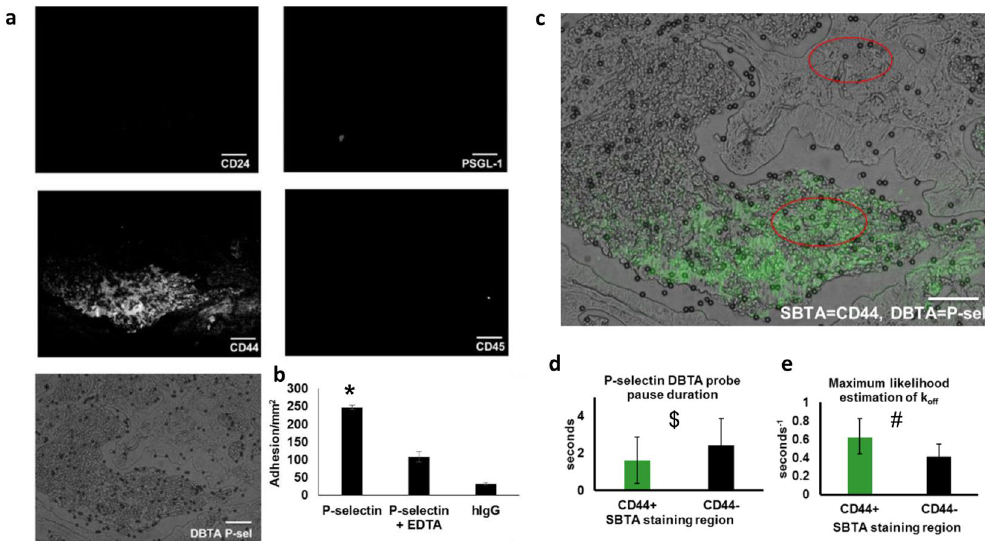
Figure 5. Adhesion in regions not detected by SBTA implies the presence of potentially distinct P-selectin ligands. ( a ) In the same regions of tissue that displayed P-selectin DBTA probe adhesion (Supplementary Video S11), examination of serial sections with SBTA (immunostaining) revealed no detectable levels of CD24 or PSGL-1 epitopes. CD44 expression was detected, but not all regions displaying specific reactivity with the P-selectin DBTA probes used in DBTA were recognized with the CD44 antibody in SBTA. Follow-up CD45 SBTA ruled out the possibility of DBTA probe interaction with infiltrated leukocytes, in agreement with the lack of PSGL-1 detection. ( b ) P-selectin DBTA probes specifically adhered to the tissue, with respect to the negative controls. Data shown are mean adhesion ± SD of three technical replicates and are representative of independent experiments conducted on tissue sections from > 3 independent cases of colon cancer. * P < 0.0025 compared to all other conditions. ( c ) A direct comparison using a composite image of P-selectin DBTA probe adhesion (microspheres) and SBTA detection of CD44 (green pseudocolor) on colon adenocarcinoma tissue. Red ellipses indicate regions analyzed in ( d , e ). (d) Characterization of the adhesion of P-selectin DBTA probes to functional selectin ligands that were and were not detected with SBTA using CD44 antibody in ( a ). Data shown are mean pause duration ± SD of 30 separate pauses (n = 30). $ P = 0.0068. ( e ) Data shown represent the estimation of P-selectin DBTA probe k off using the method of maximum likelihood from 30 separate pauses (n = 30). Error bars represent 95% CI. # Mann-Whitney U-value = 1152.5 (equivalent to P < 0.001 for t-test for normal distribution). All probes were perfused at 500,000 probes/mL and 0.50 dyne/cm 2 . Specificity of interaction was confirmed using 10 mM EDTA and hIgG DBTA probes as negative controls. Scale bar = 100 µ